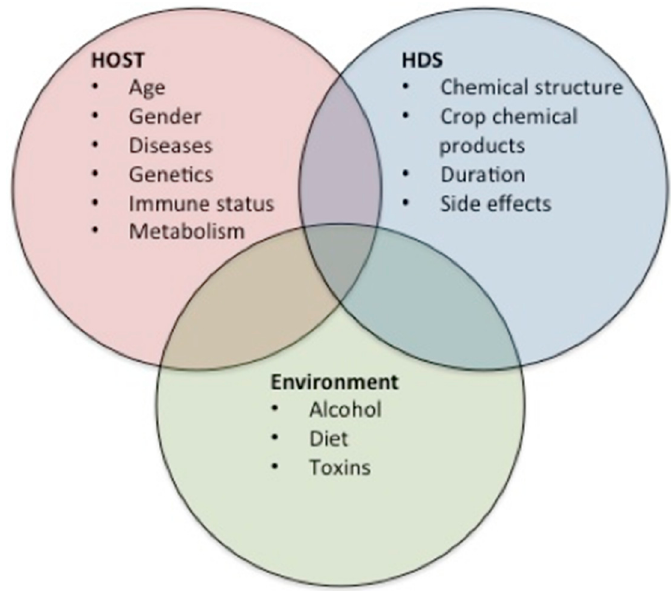
Figure 2. HILI Pathogenesis. This figure illustrates the various theories of the pathogenesis of herb- induced liver injury (HILI). Most of these overlap with those for drug-induced liver injury